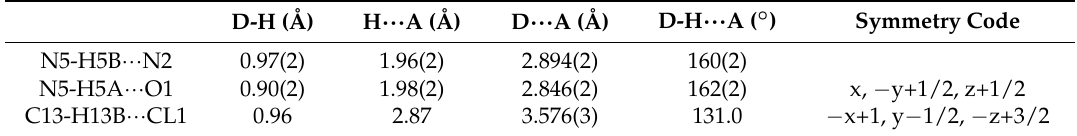
Table 2. Parameters of intramolecular and intermolecular interactions for compound 7 .